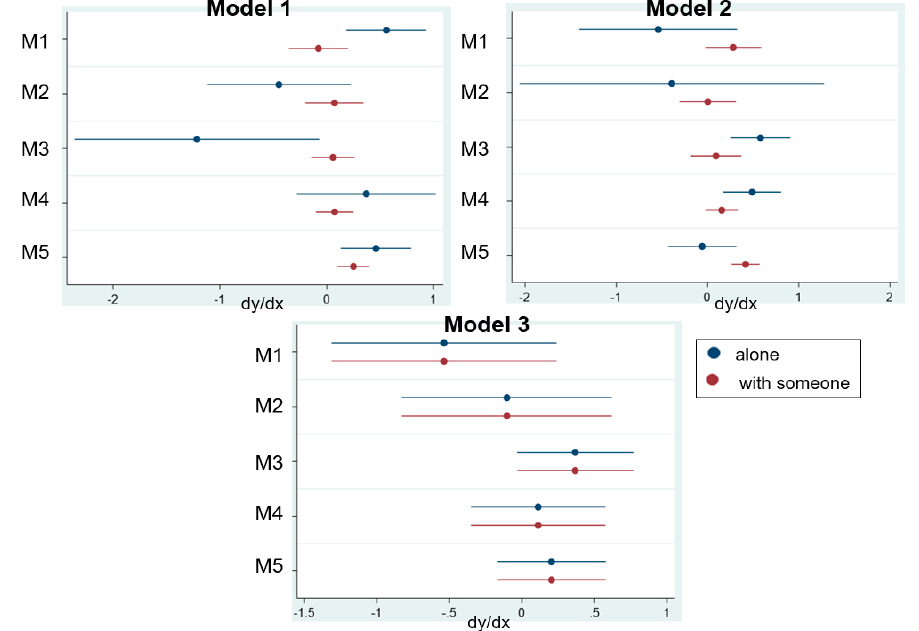
Figure 3. Marginal effects of eating pattern on participation effects by motivation.dy/dx is the discrete change in participation effects of margins by motivation with an eating pattern based on the fitted Poisson regression model in Table 2 (Supplementary Materials, Table S2).